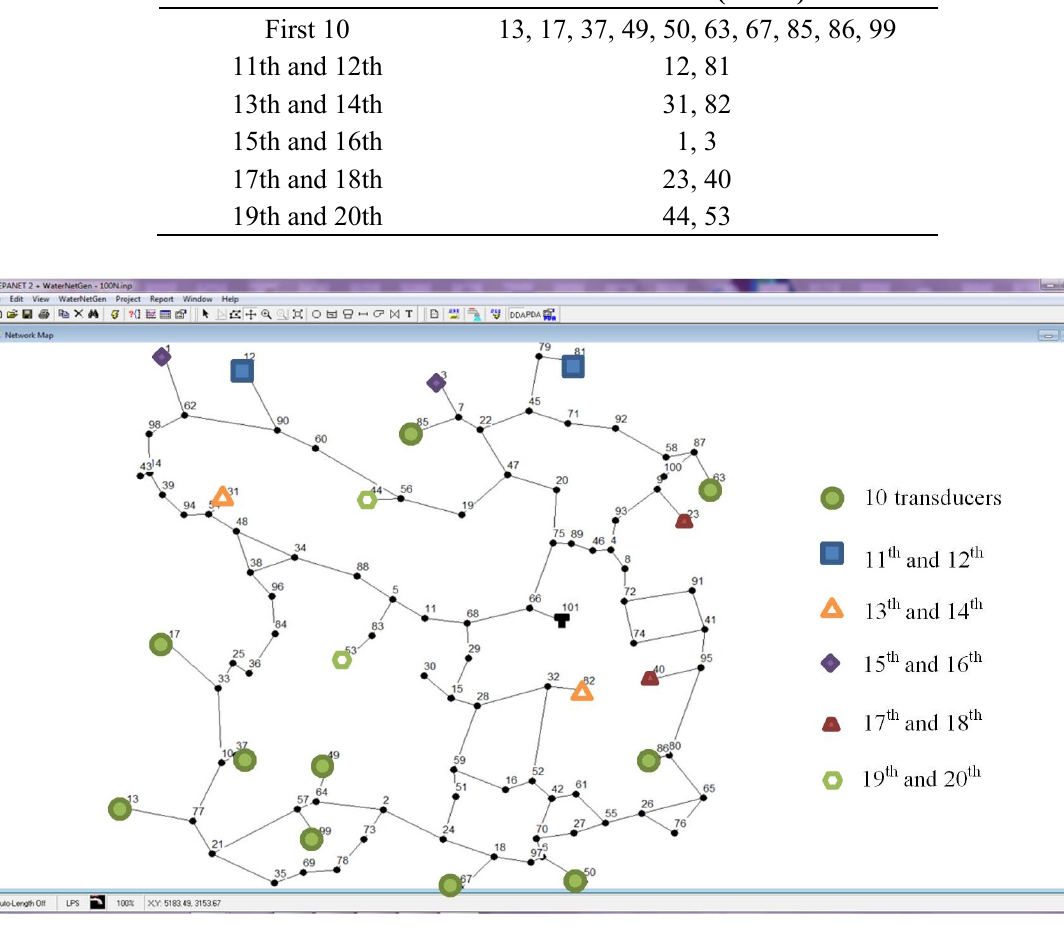
Figure 4. Network layout with the pressure transducers